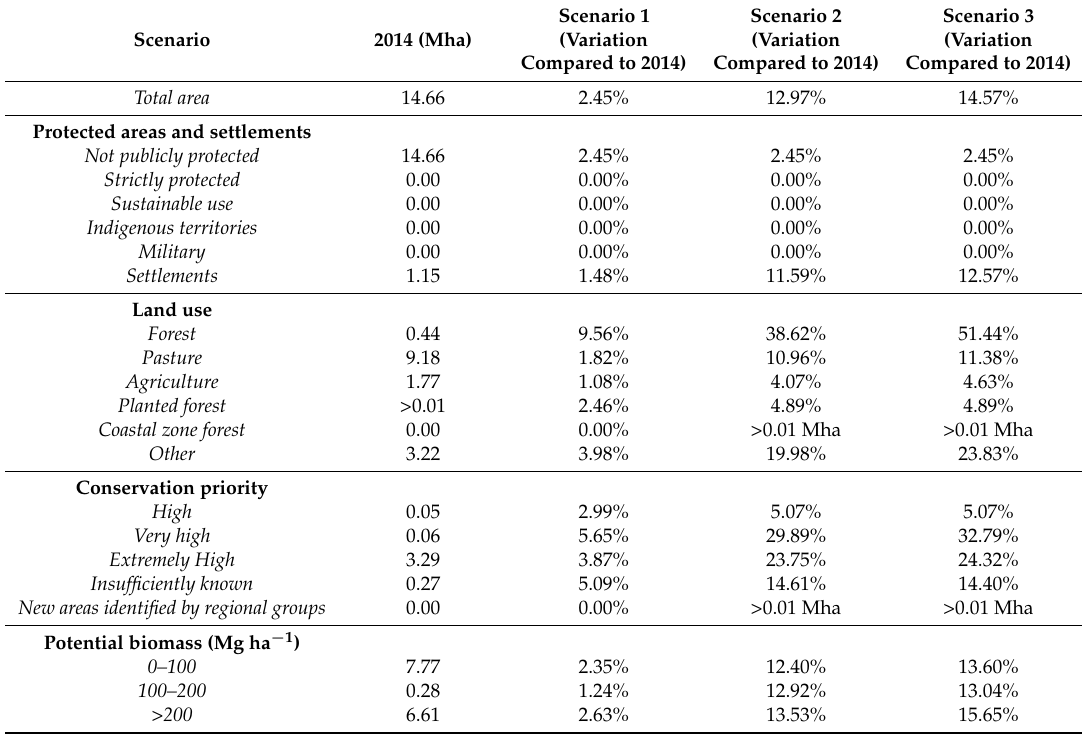
Figure 4. Changes in soy expansion probabilities due to infrastructure improvements between the 2014 scenario (Panel A ) and future Scenarios 1, 2 and 3 (Panels B , C , and D , respectively). Table 3. Changes in the high-risk areas of experiencing soy expansion in the Brazilian Legal Amazon across simulation